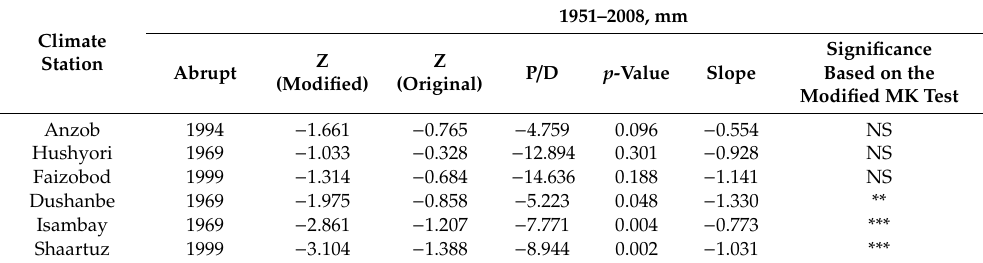
Figure 5. Inter-annual variability and trends of annual temperature during the 1951–2012 time period in the Kofarnihon River Basin, Central Asia. Table 7. The annual precipitation trend, the precipitation per decade (P / D), the Sen’s slope, the abrupt-point analysis, and the original and modified Mann–Kendall (MK) tests for the trends (Z) in the Kofarnihon River Basin, Central